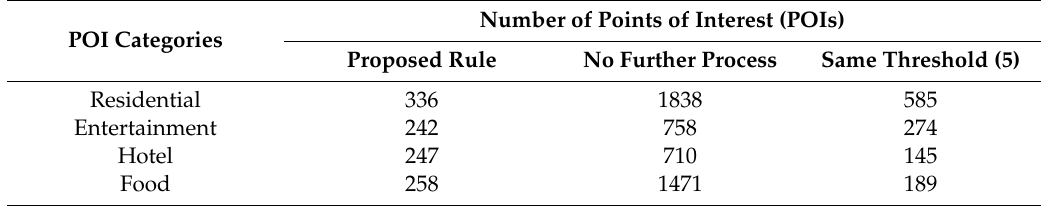
Table 1. Description of dataset selected from different rules.